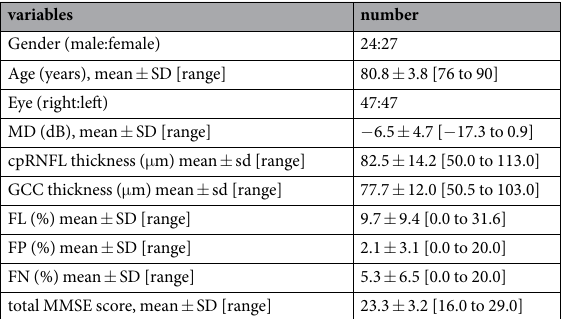
Table 1. Patient demographics. SD: standard deviation, MD: mean deviation, cpRNFL: circumpapillary retinal nerve fiber layer, GCC: ganglion cell complex, FL: fixation loss, FP: false positive, FN: false negative, MMSE: Mini Mental State